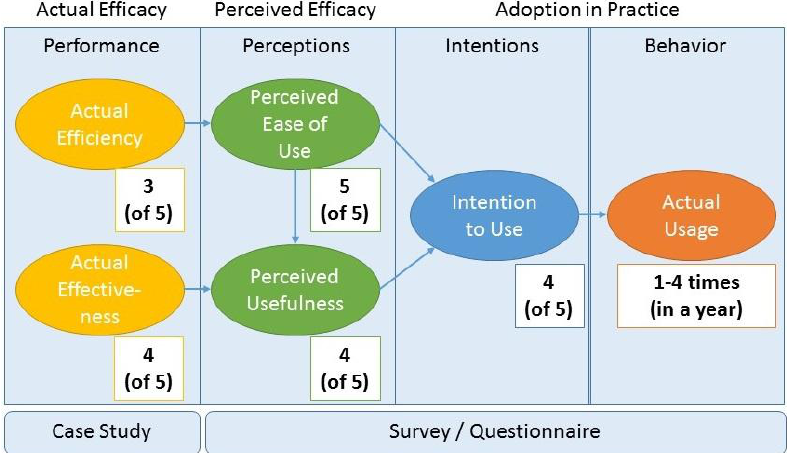
Figure 8. Method evaluation model including average results of Survey and Case